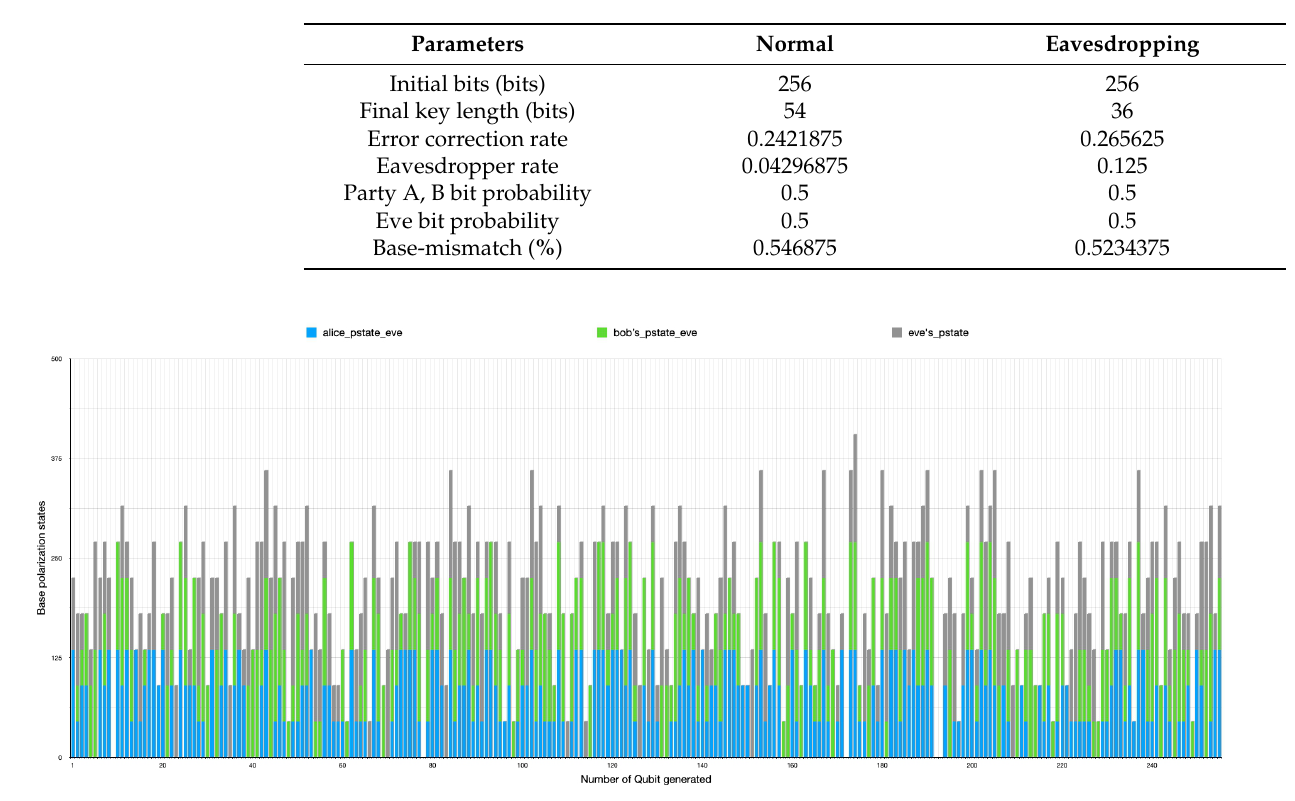
Table 2. Comparison of base parameters used and obtained results from the two main simulation instances.